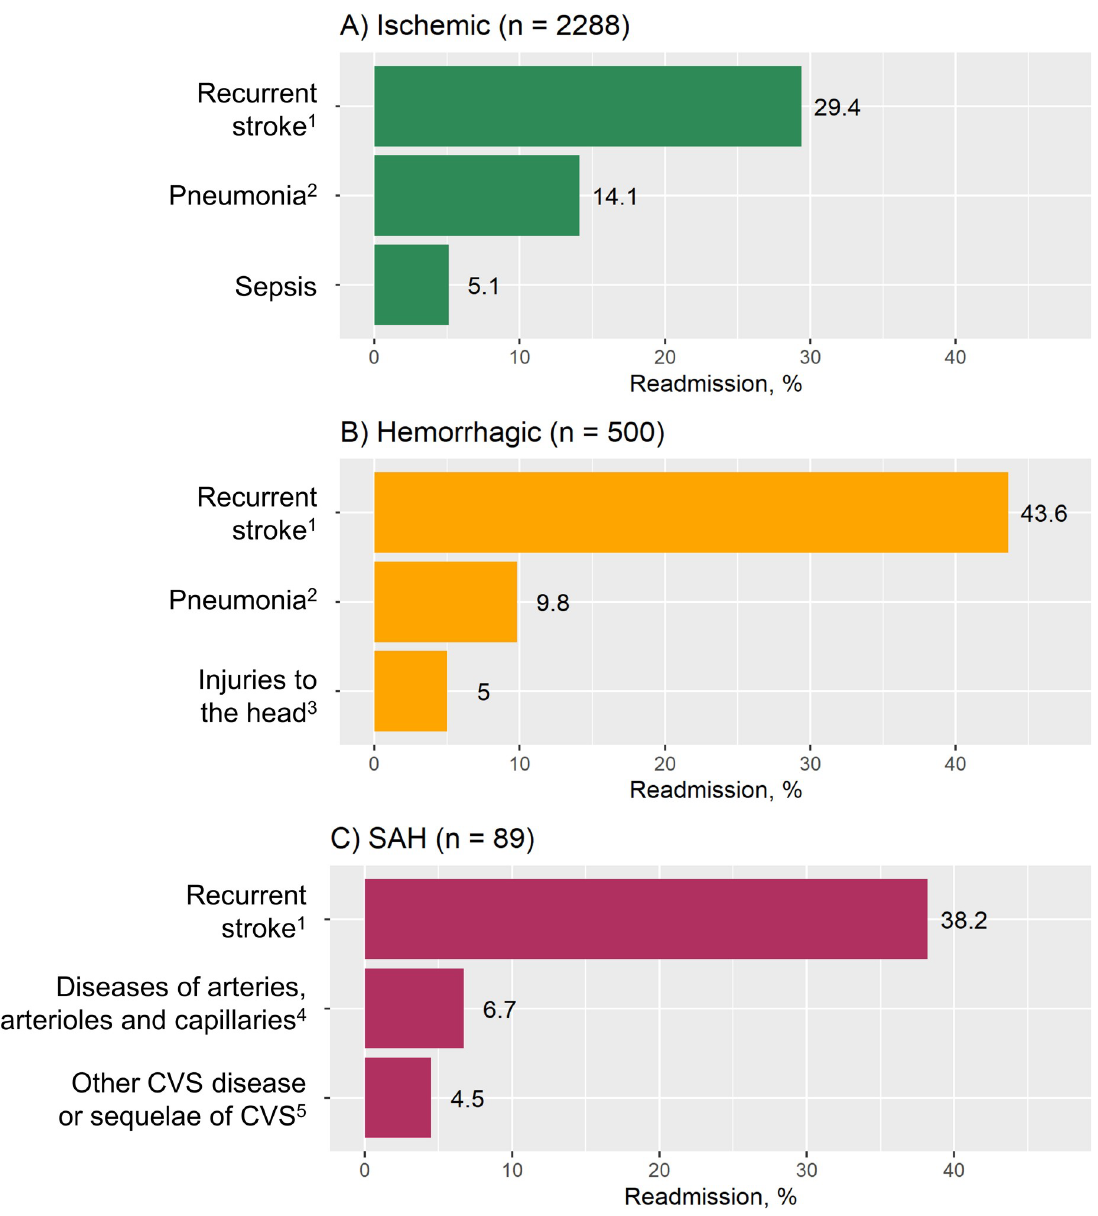
Fig 4. Top causes of 28-day readmissions in 2015 by stroke subtypes. A) Ischemic stroke. B) Hemorrhagic stroke. C) Subarachnoid hemorrhage. 1 Recurrent stroke includes I60–I64 and G45. 2 Pneumonia also includes J69. 3 Majority (n = 18, 72.0%) were intracranial injury. 4 Consisted of aortic (n = 1, 16.7%) and other (n = 5, 83.3%) aneurysm and dissection. 5 Consisted of 3 (75.0%) other cerebrovascular disease (CVS) and 1 (25.0%) sequala of